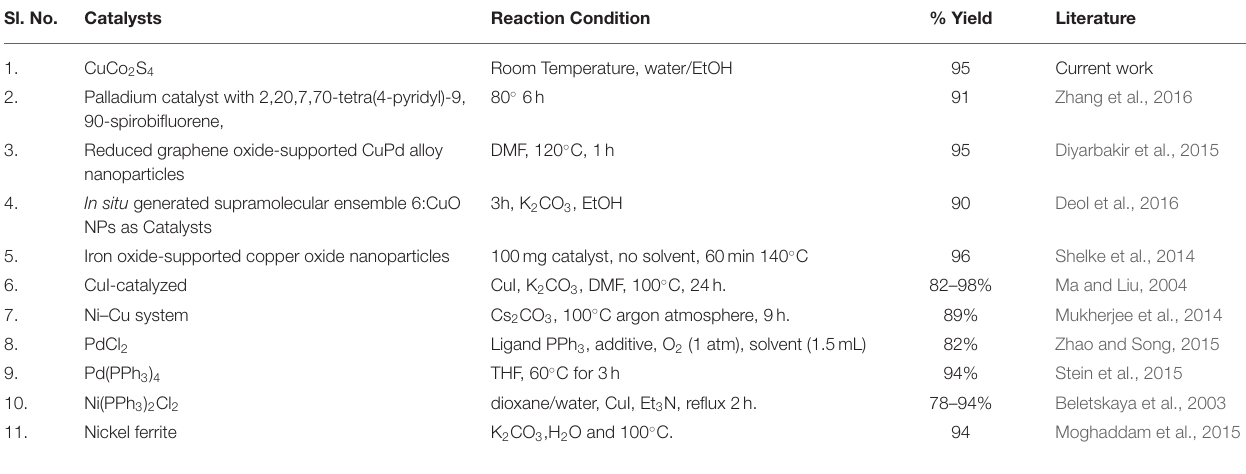
TABLE 3 | Comparison of the catalytic properties (synthesis of diphenylaceteylenes) between present CuCo 2 S 4 nanosheets and literature reports. Sl.